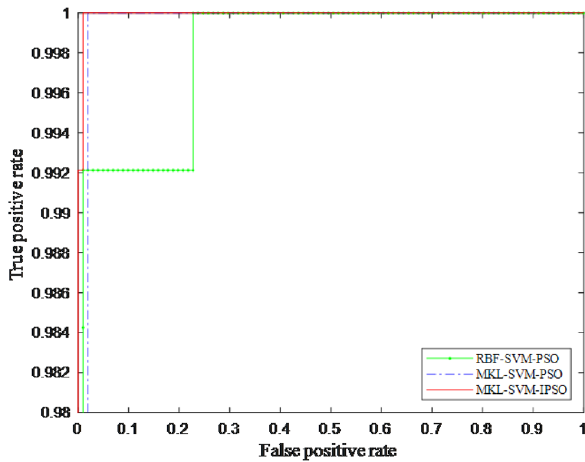
Figure 8. ROC curves of different recognition algorithms.